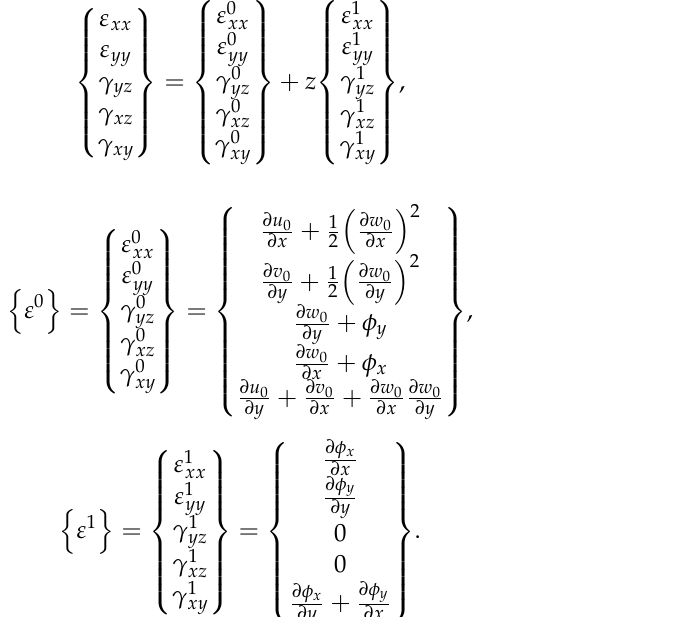
Figure 1. Undeformed and deformed geometries of an edge of a plate under the assumption of the first-order shear deformation theory